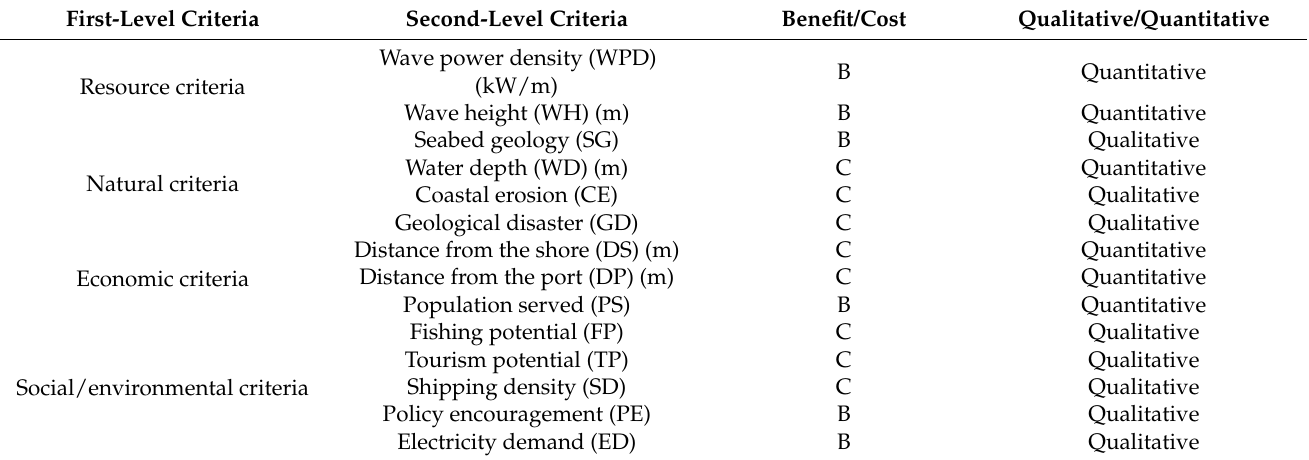
Table 1. Evaluation